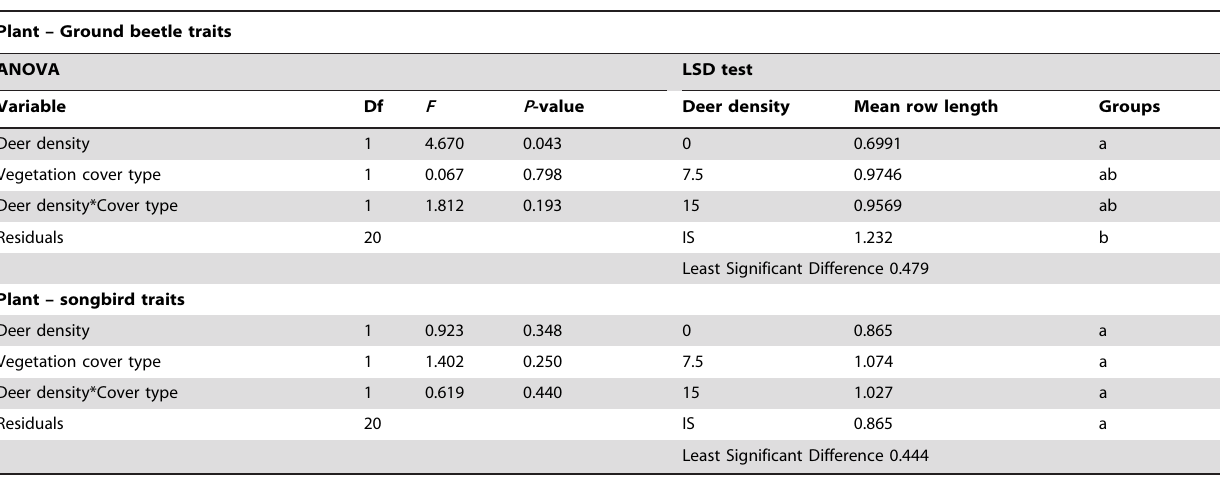
Table 4. Two-way analysis of variance (ANOVA) of the mean arrow length in the co-inertia analysis for the factors deer density (0, 7.5, 15 deer ? km 2 2 and in situ : IS) and vegetation cover type (uncut forests and cut-over areas), and their